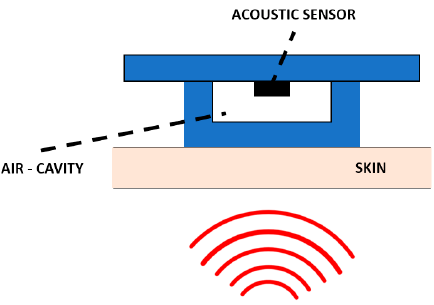
Figure 13. Working principle of the air–silicone composite device as presented in [128].